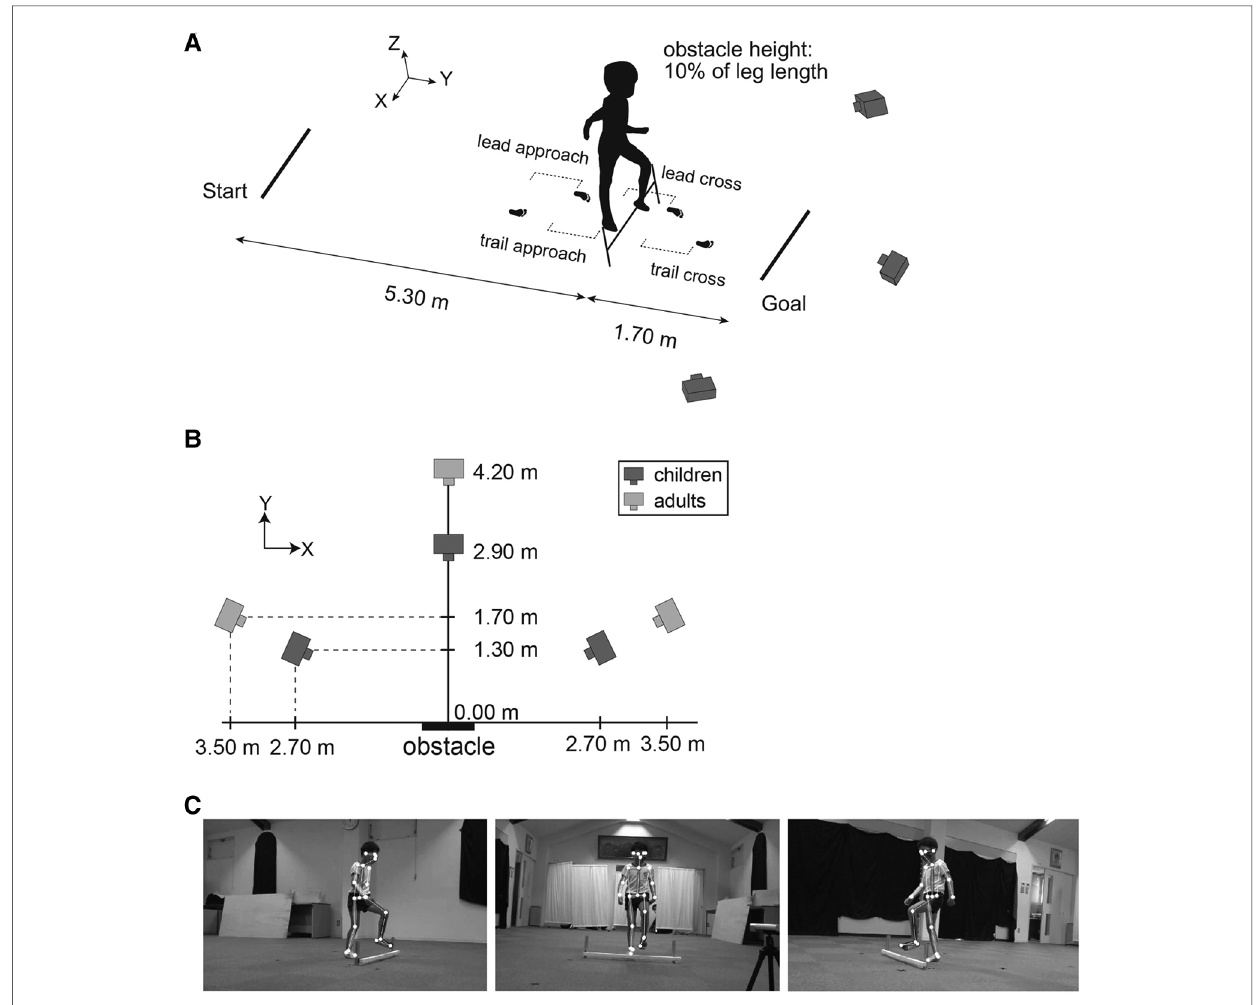
FIGURE 1 Experimental setup and overview of estimating body feature points by OpenPose. ( A ) Obstacle-crossing tasks were recorded by three RGB video cameras placed in front [perspective in ( C ), middle image] and diagonally in front [perspective in ( C ), left and right images] of an obstacle. The data from a total of 4 steps, including two steps before crossing the obstacle (called the lead approach step and trail approach step) and two steps during crossing the obstacle (called the lead cross step and trail cross step), were analyzed. ( B ) Camera positions for the children were closer to the obstacle than those for the adults. ( C ) OpenPose was applied to the three recording videos to estimate the 2D coordinates of the 25 body landmarks; these coordinates were transformed into 3D coordinates using a direct linear transformation